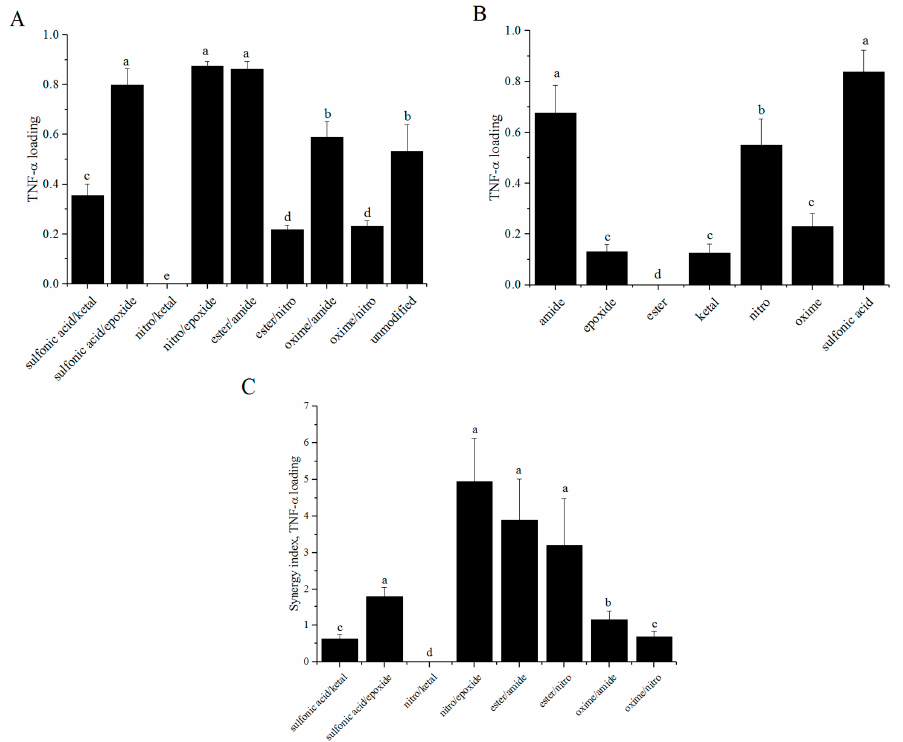
Figure 7. Modified alginates alter mass transport of TNF- α through layered alginate particles. ( A ) Combined; and ( B ) single modified alginates were layered over alginate particles containing mouse IgG labeled polystyrene particles. n = 4. Data represent the mean value ± standard deviation. Bars with the same letter (a–d) are not statistically different ( p < 0.05) from data points of the same activation.